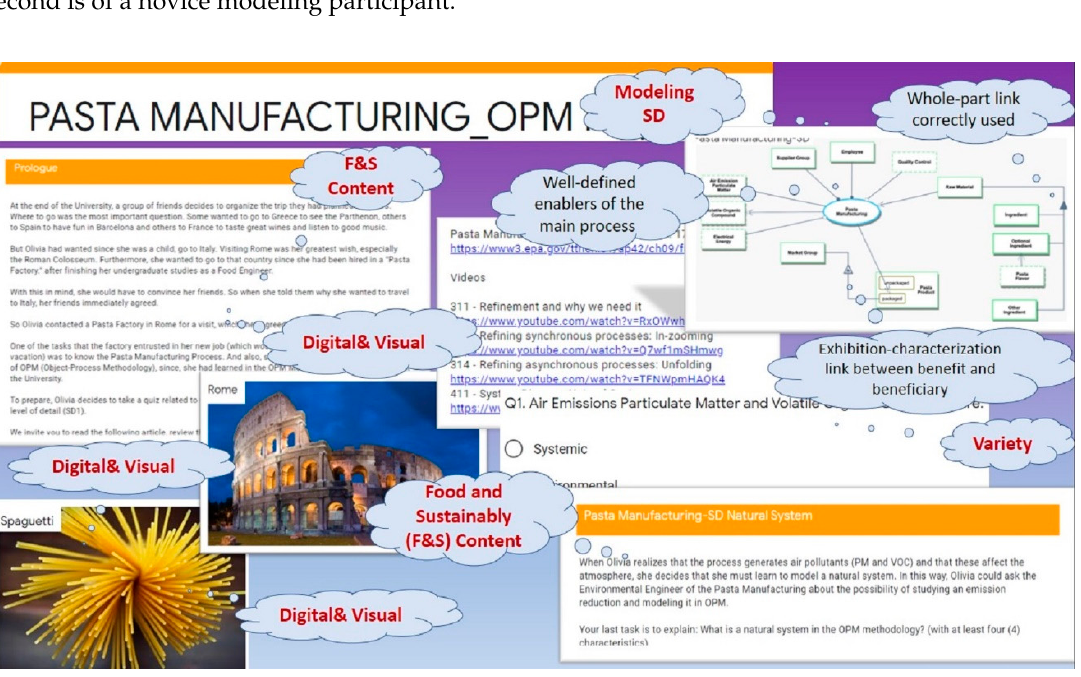
Figure 6. Selected segments of the final assignment submitted by participant #722122205.